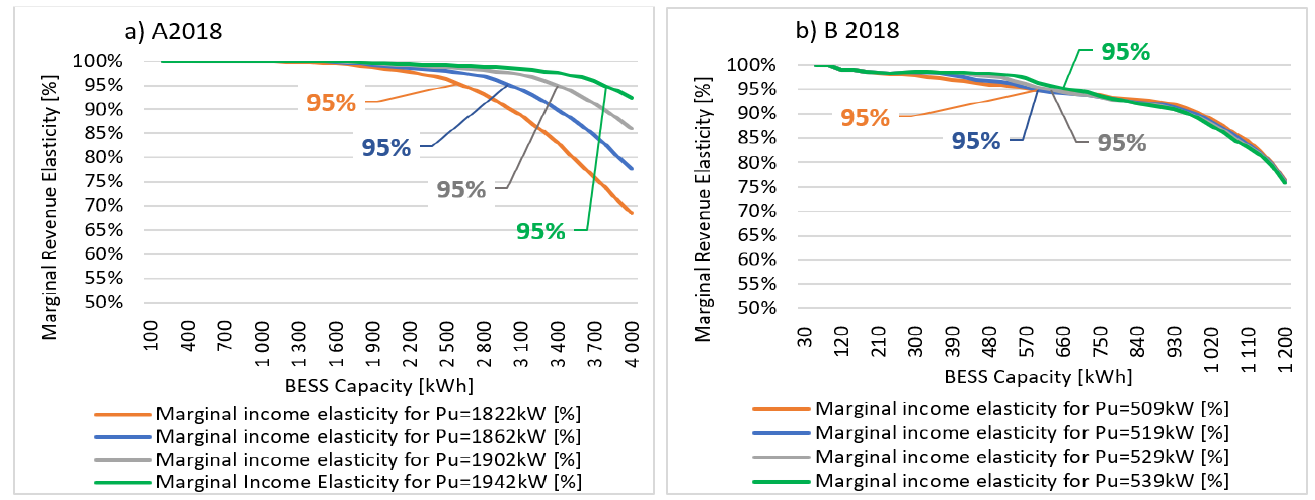
Figure 7. The results of the price arbitrage simulation with different contractual powers Pu [kW] for enterprises ( a ) A2018; ( b ) B2018. enterprises ( a ) A2018; ( b ) B2018.